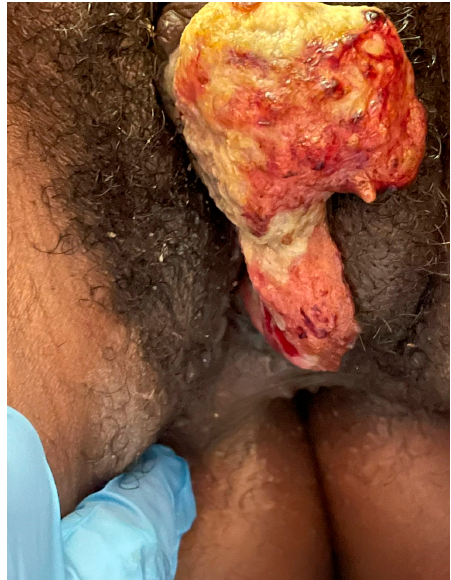
Figure 1. Prior to treatment.